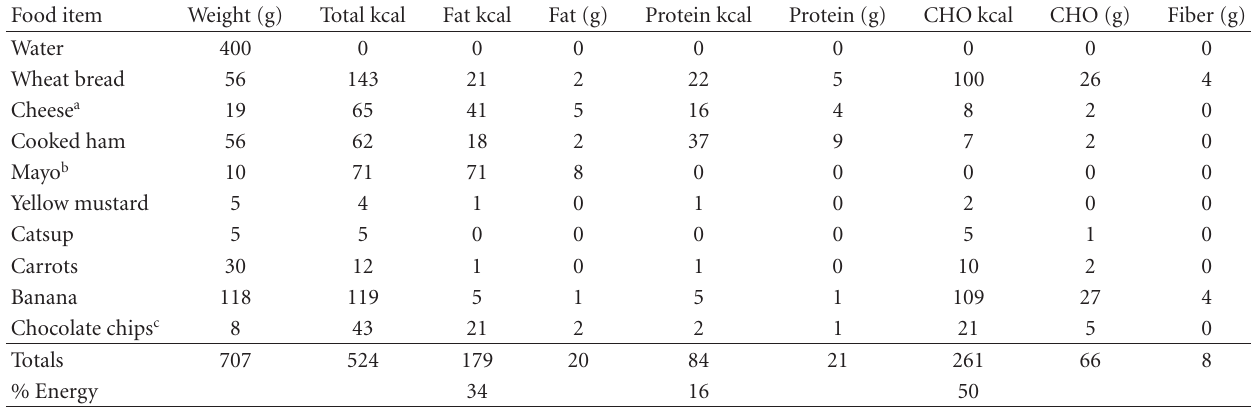
Table 2: Composition of the standard study